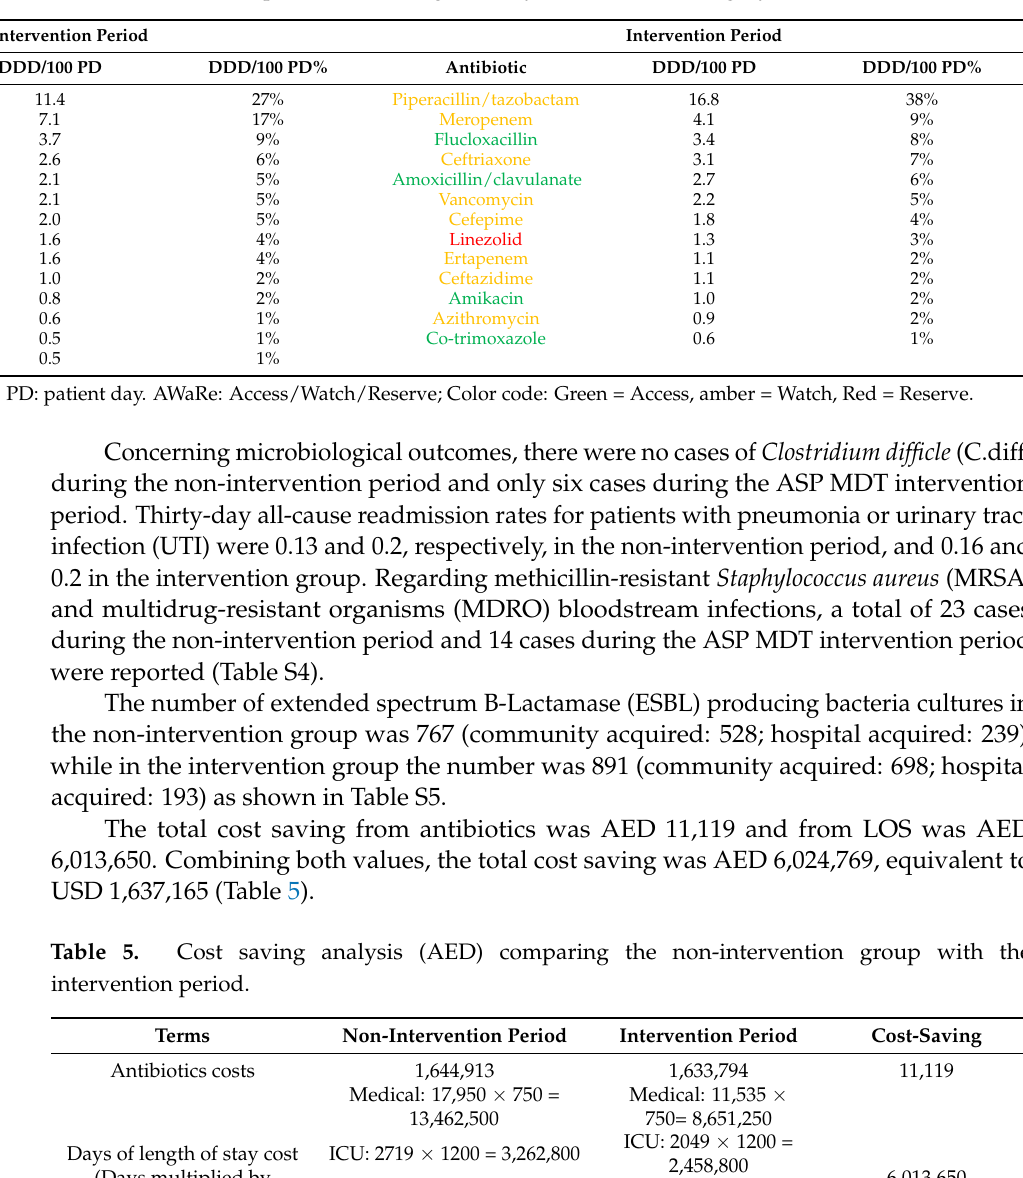
Table 4. Antibacterial consumption in all three settings (medical, ICU, burns), contributing to 90% of total antibiotic use in the non-intervention and ASP MDT intervention periods, and categorised by WHO AWaRe category.